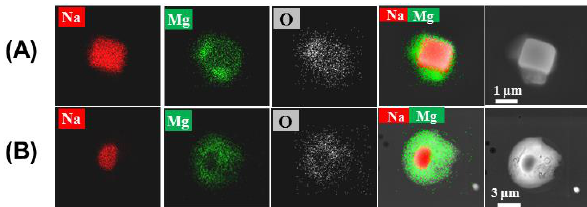
Figure 9. Elemental X-ray maps for Na (from NaCl), Mg (from (cid:113) x H 2 O), and mixed Na/Mg and sec- MgCl 2 ) , O (from MgCl 2 ondary electron images (SEIs) of the effloresced NaCl–MgCl 2 mix- ture particles with compositions of (a) X NaCl = 0.9 (NaCl-rich, seawater-like mixing ratio) and (b) X NaCl =